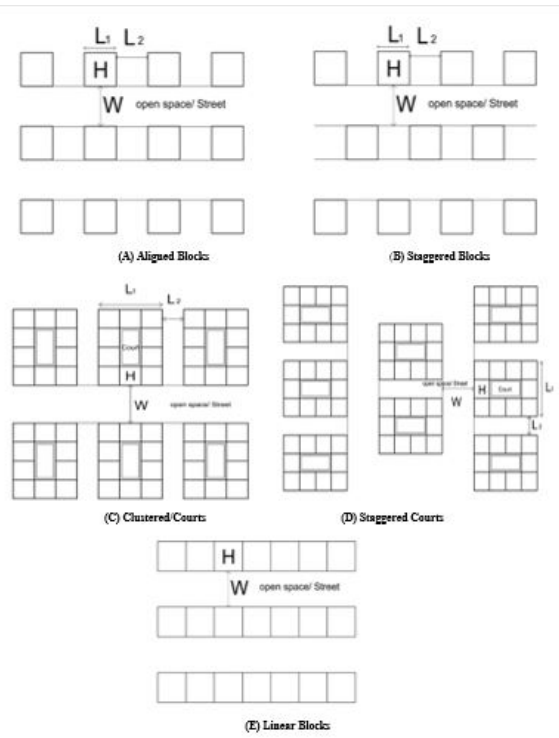
Figure 1. Most dominantly used urban patterns in residential